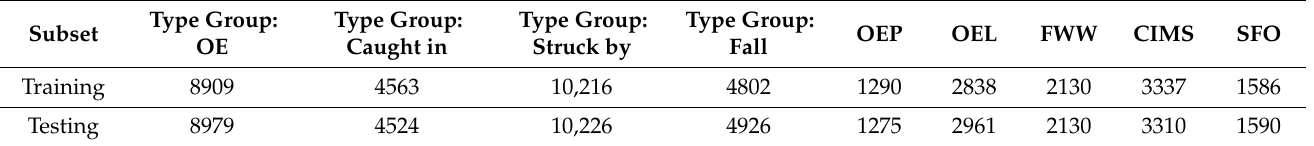
Table 2. Various accident categories in the training and testing subsets. Each subset has 40,649 samples.